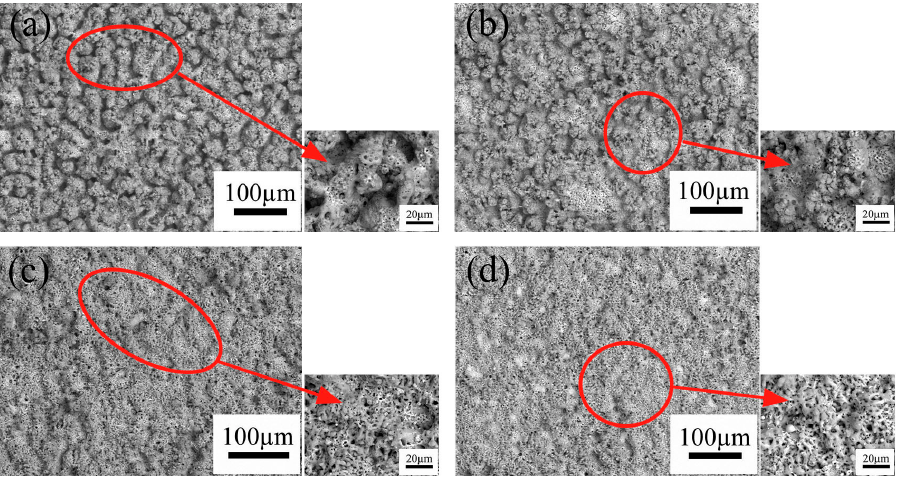
Figure 2. Surface morphologies of various MAO coatings formed in different K 2 ZrF 6 concentrations: ( a ) 0 g/L; ( b ) 3 g/L; ( c ) 6 g/L; ( d ) 9 g/L.